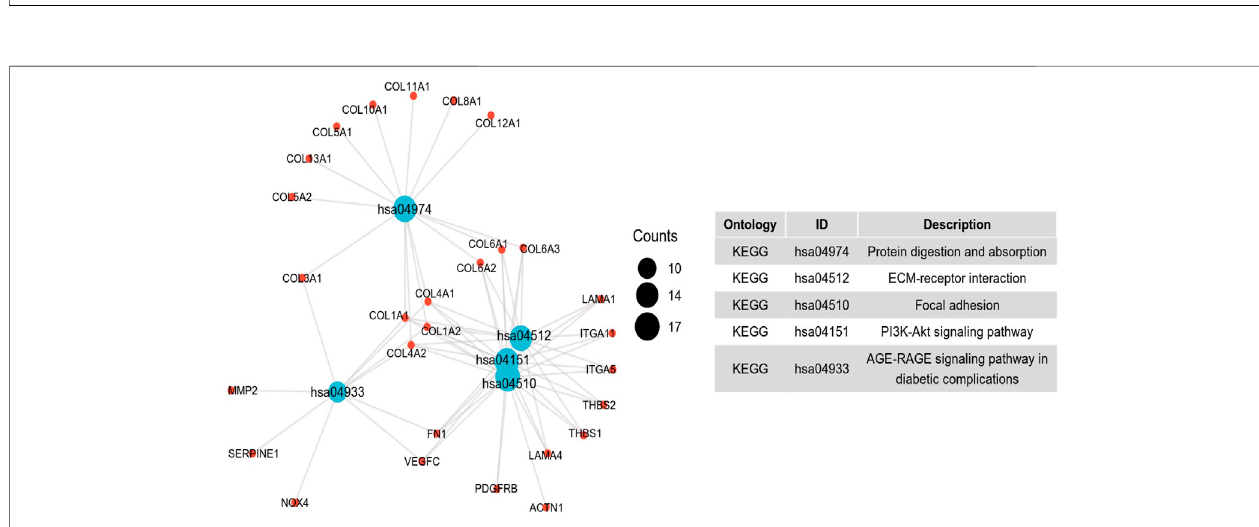
FIGURE 4 | Signi fi cant KEGG pathway of the top 100 genes most positively associated with INHBA .